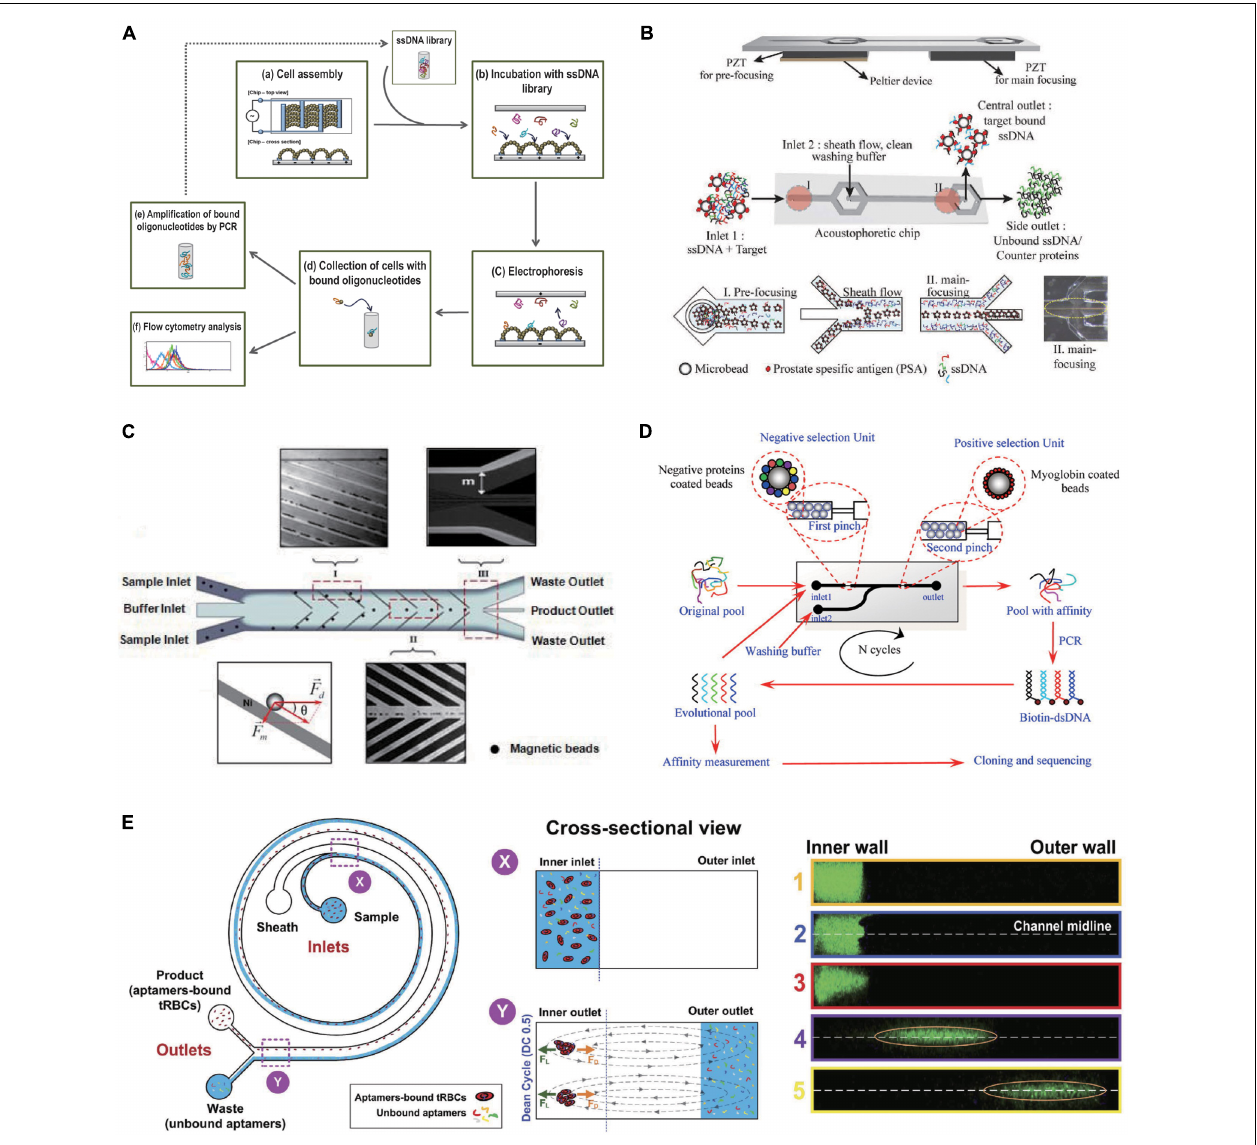
FIGURE 3 | Force field driven microfluidic chips. (A) Dielectrophoresis and electrophoresis combined microfluidic chip for performing cell-SELEX procedure. (B) The schematic overview of the acoustophoretic device and SELEX process. (C) Design of the CMACS microfluidic SELEX device. (D) Myoglobin-aptamer selection microfluidic chip. The positive and negative selection unites are integrated in one micro-channel. Reprinted with permission from Wang et al. (2014). Copyright 2014 American Chemical Society. (E) Inertial microfluidic SELEX (I-SELEX) utilizing Dean vortices to select aptamers for red blood cells